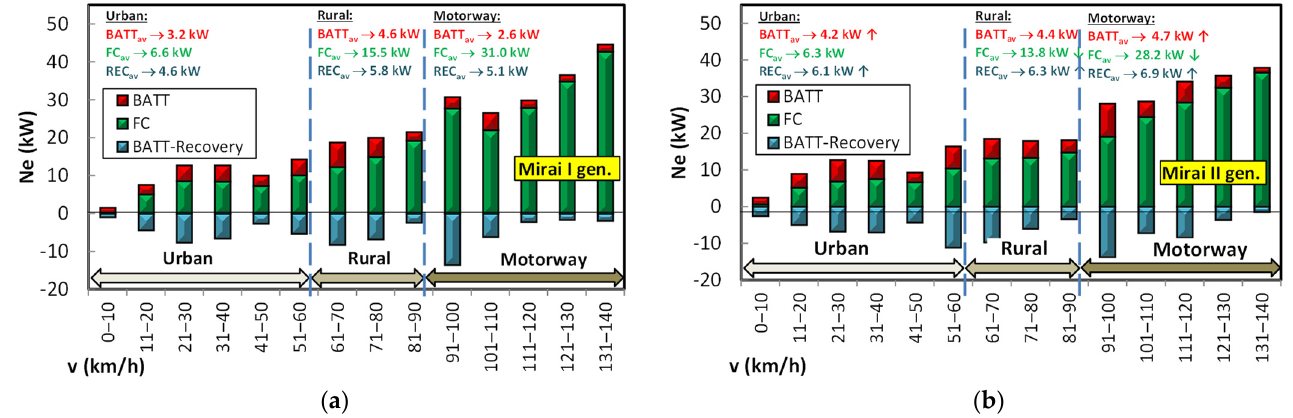
Figure 14. Mean battery and fuel cell power values assigned between respective vehicle the speed ranges; additionally, the mean data on the respective powers were given, broken down into the test drive sections: ( a ) for the first generation of the drive; ( b ) for the second generation of the drive.